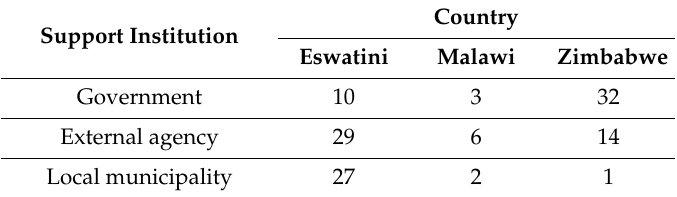
Table 6. Proportion (%) of respondents citing support in craft production and